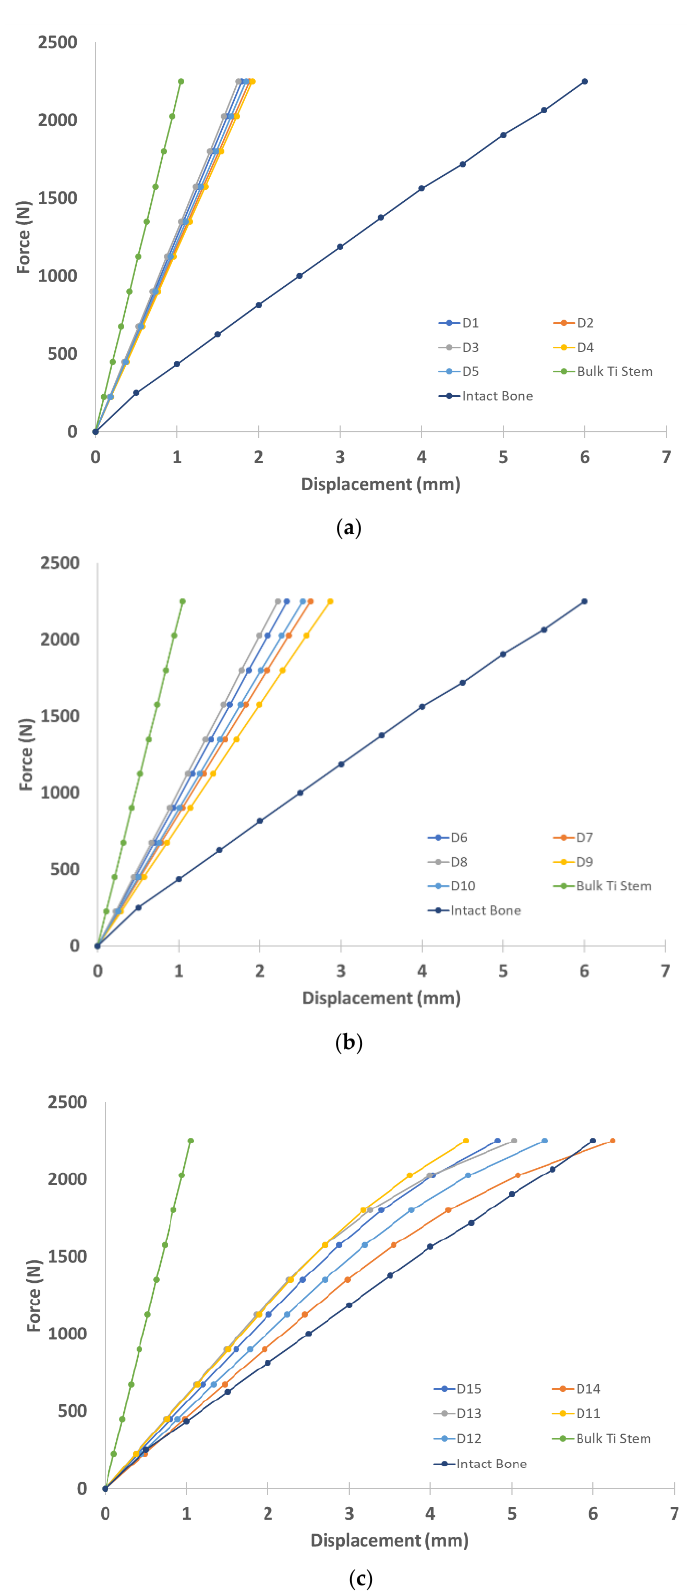
Figure 9. Force–displacement diagram for stem designs with ( a ) 30%, ( b ) 50%, and ( c ) 70% volumetric porosities, respectively, along with intact bone and bulk Ti stem.